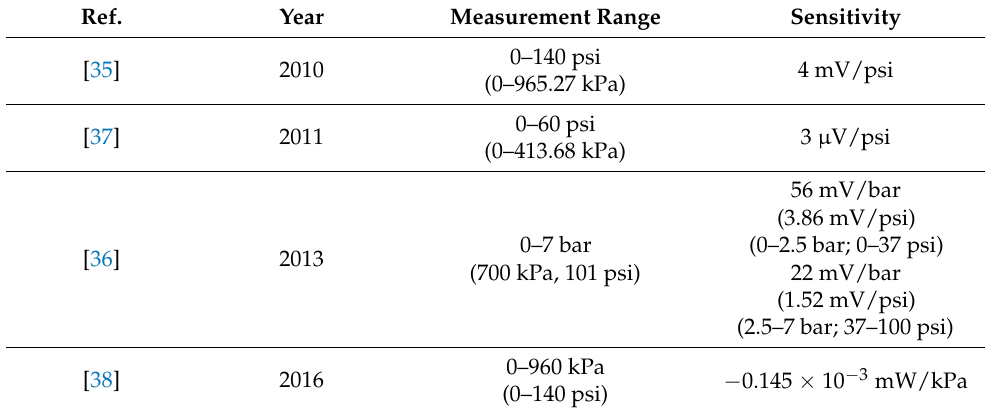
Table 1. Summary of the relevant parameters of MMI pressure